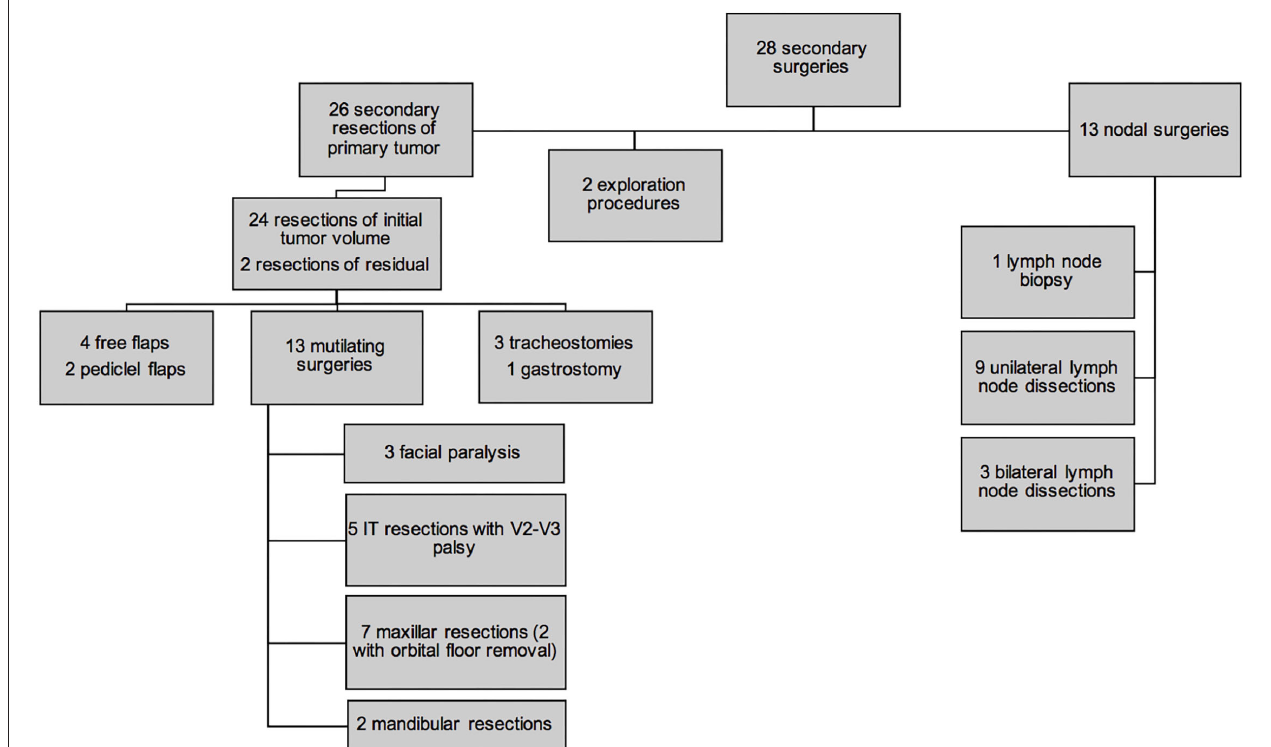
FIGURE 2 | Local and nodal strategy for secondary surgery. IT, infratemporal; V2–V3: maxillary (V2) and mandibular (V3) nerves.